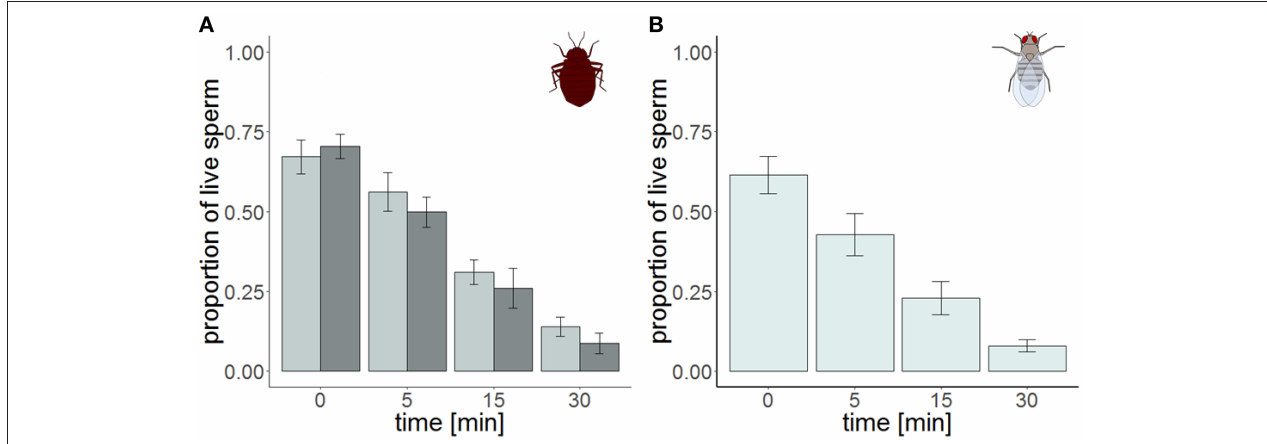
FIGURE 3 | Sperm viability in the cranial (dark gray) and the caudal (light gray) part of the seminal vesicle of Cimex lectularius ( A , n = 10) and in seminal vesicle of Drosophila melanogaster ( B , n = 10) at four different points in time. Bars show mean ± s.e.